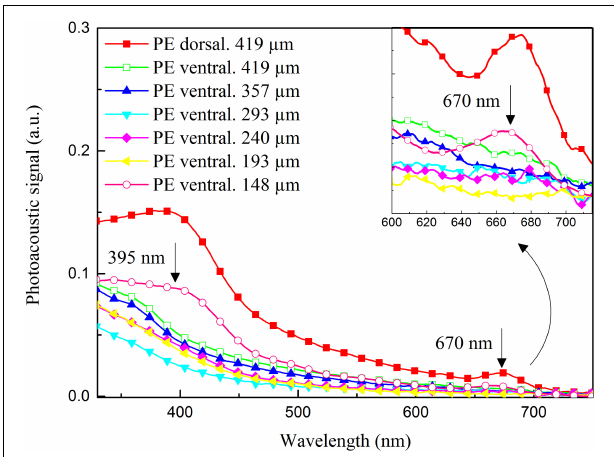
FIGURE 5 | Photoacoustic spectra of nail sample after 24 h of treatment with propolis extract (PE), for different thicknesses. Surface of application of PE (PE dorsal, 419 µ m); first measurement without filing the layer on the side opposite to the application site (PE ventral. 419 µ m); consecutive measurements after filing the nail layer on the side opposite to the application site until optical absorption bands of PE were detected (PE ventral. 357 µ m; PE ventral. 293 µ m; PE ventral. 240 µ m; PE ventral. 193 µ m; PE ventral. 148 µ m). Arrows indicate the presence of characteristic bands of PE in 148- µ m-thick nail layer, highlighting the band centered at 670 nm.